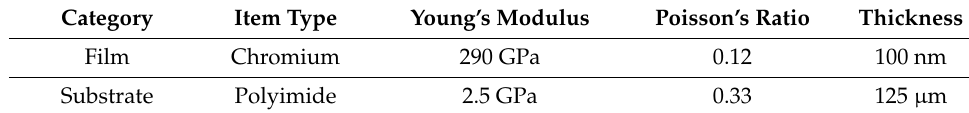
Figure 7. Sketch of the tensile specimen (unit: mm). Table 1. Elastic and geometric parameters of substrates and films. Table 1. Elastic and geometric parameters of substrates and films.